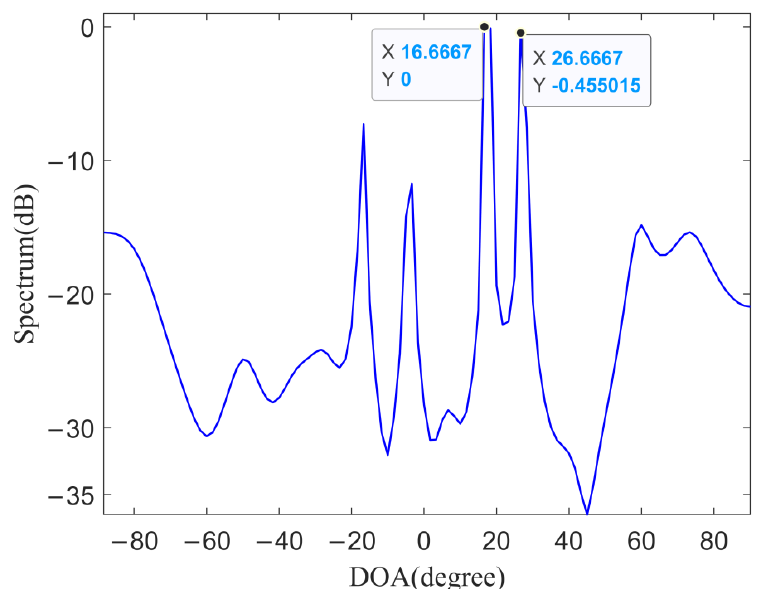
Figure 20. The third strong co-channel interference spatial spectrum.